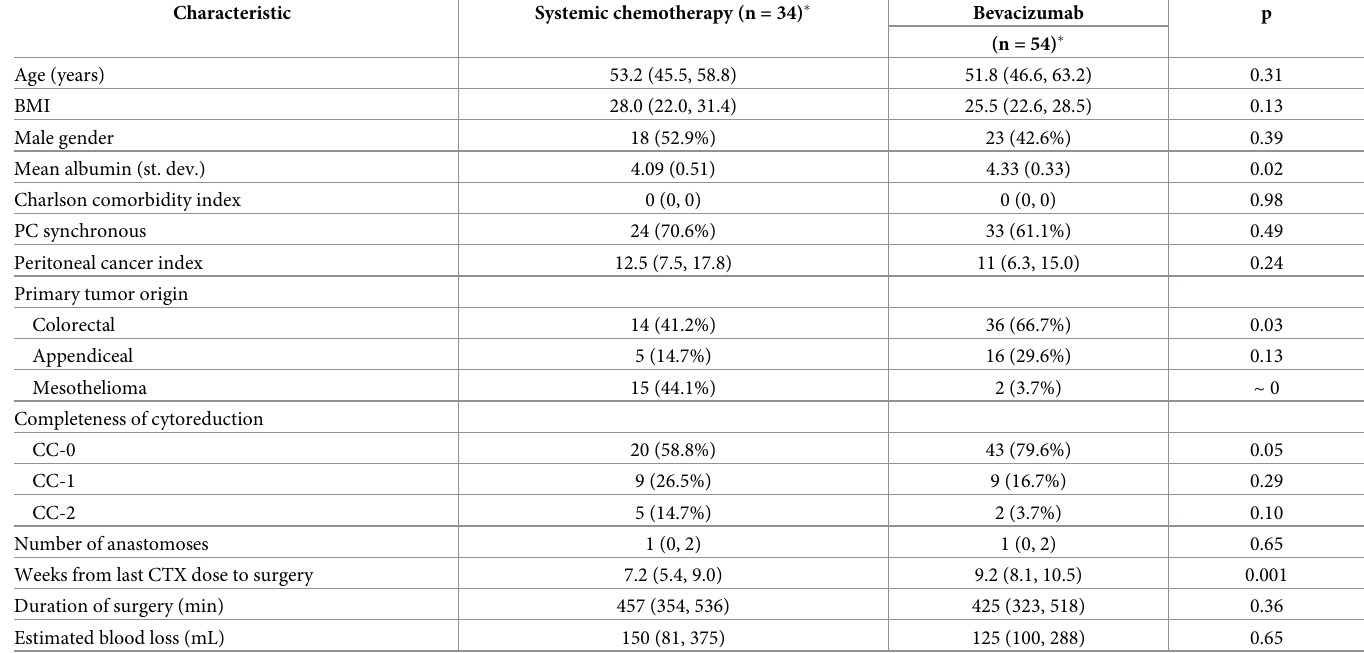
Table 1. Characteristics of patients receiving systemic chemotherapy alone (‘systemic chemotherapy’) or in combination with bevacizumab (‘bevacizumab’) prior to CRS/HIPEC.